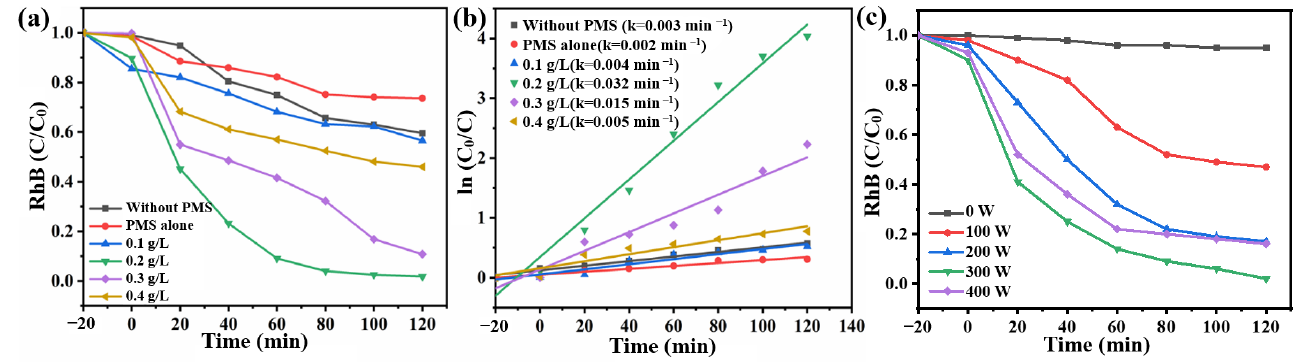
Figure 3. ( a ) The effect of PMS concentration on RhB degradation. ( b ) Reaction kinetics. ( c ) The effect of ultrasound power on RhB degradation.